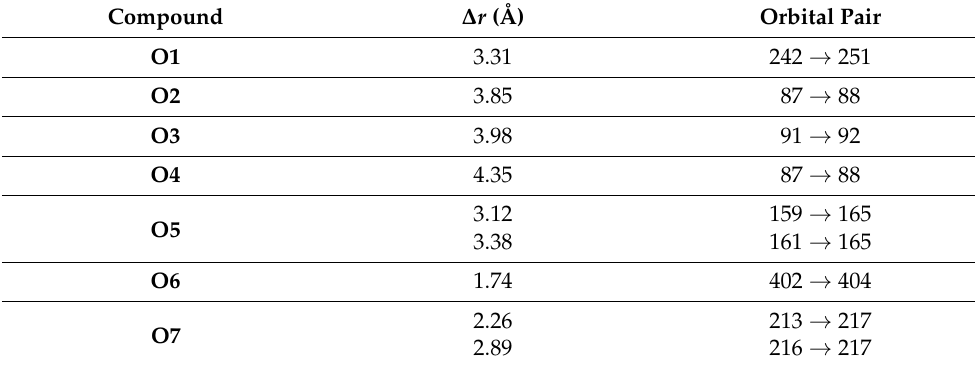
Table 11. Charge-transfer lengths ( ∆ r ) for the first excited state within each compound.